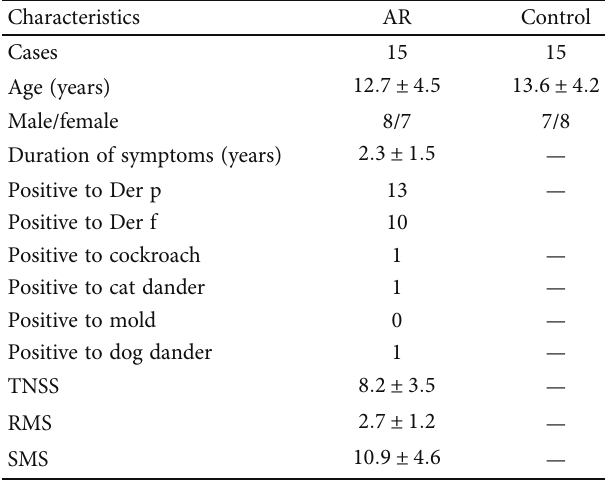
Table 1: Characteristics of subjects.